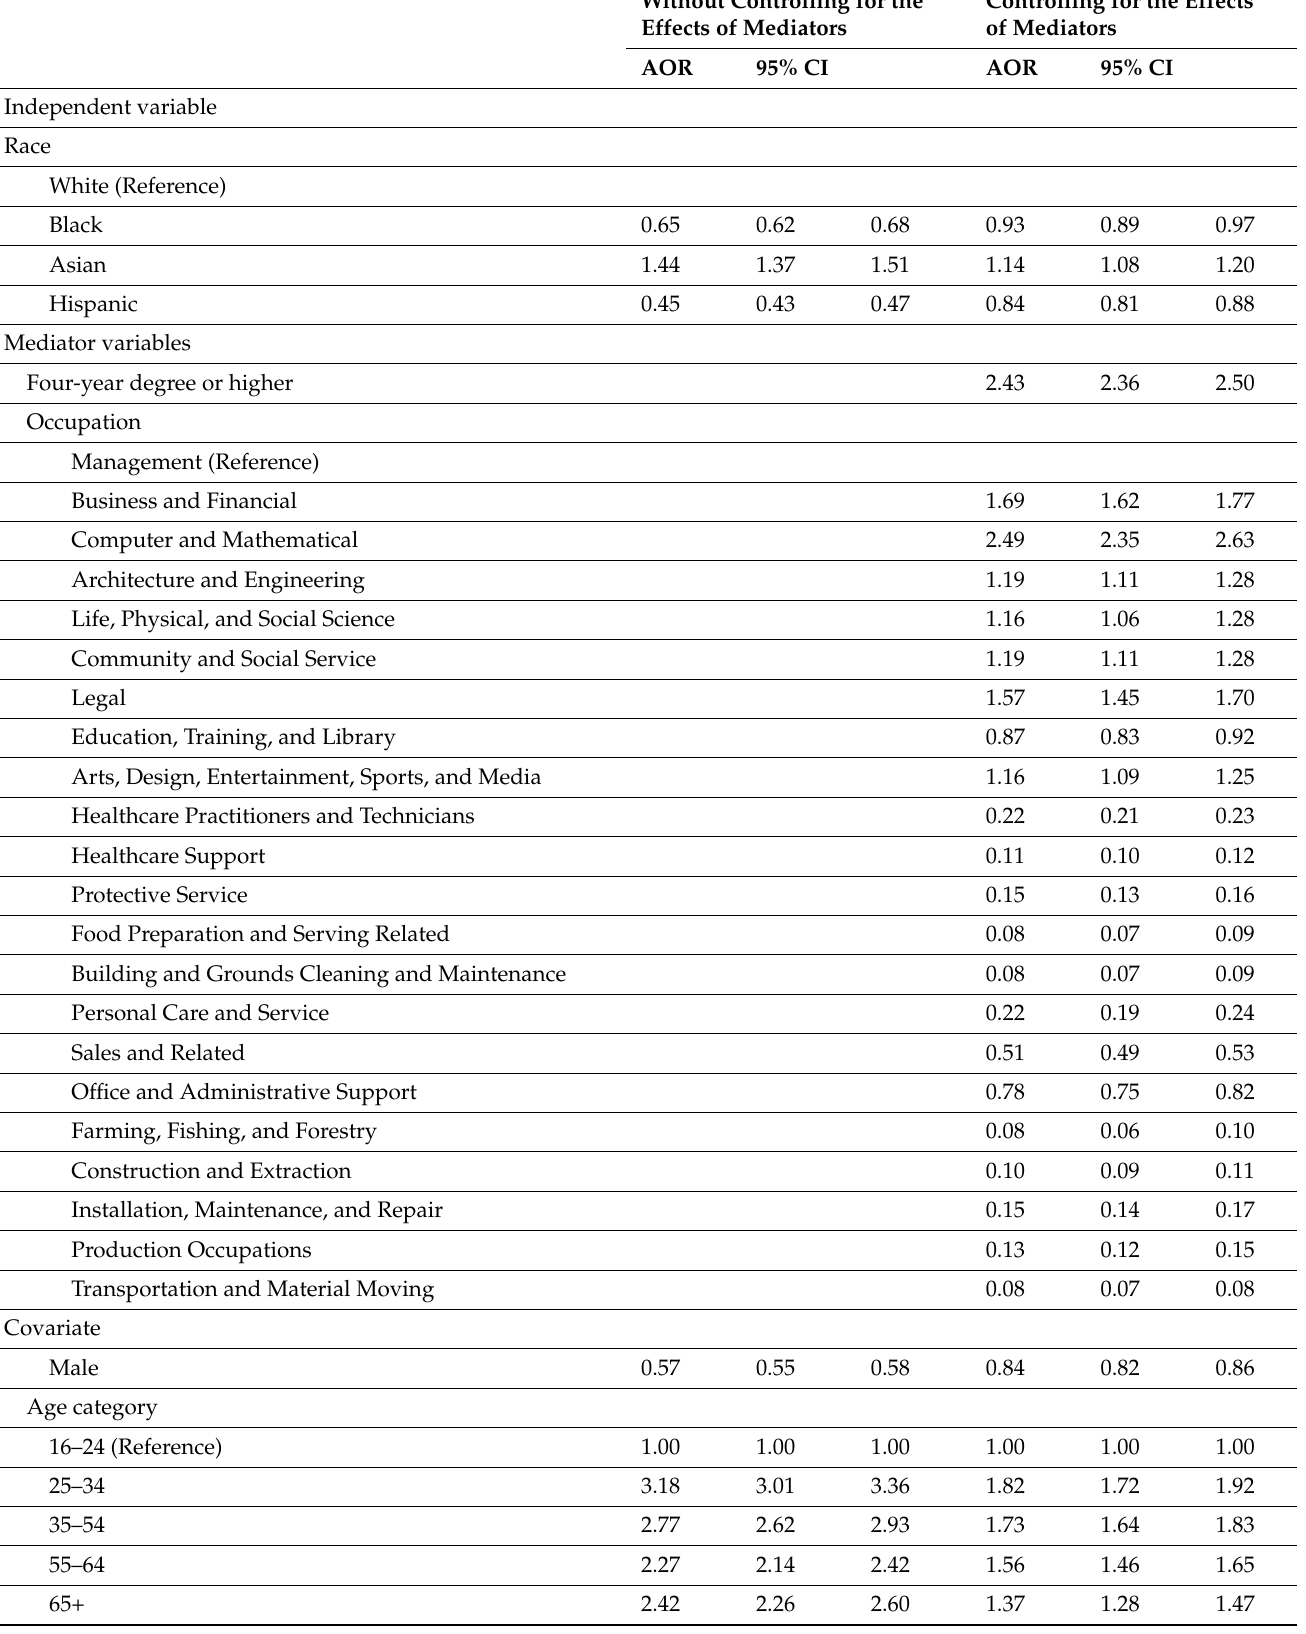
Without Controlling for the Effects of Mediators